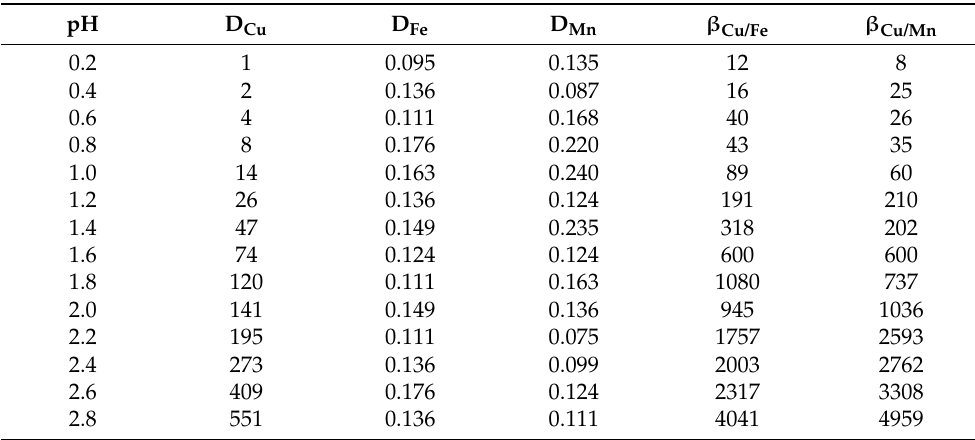
Table 2. The values of separation factors at different pH.